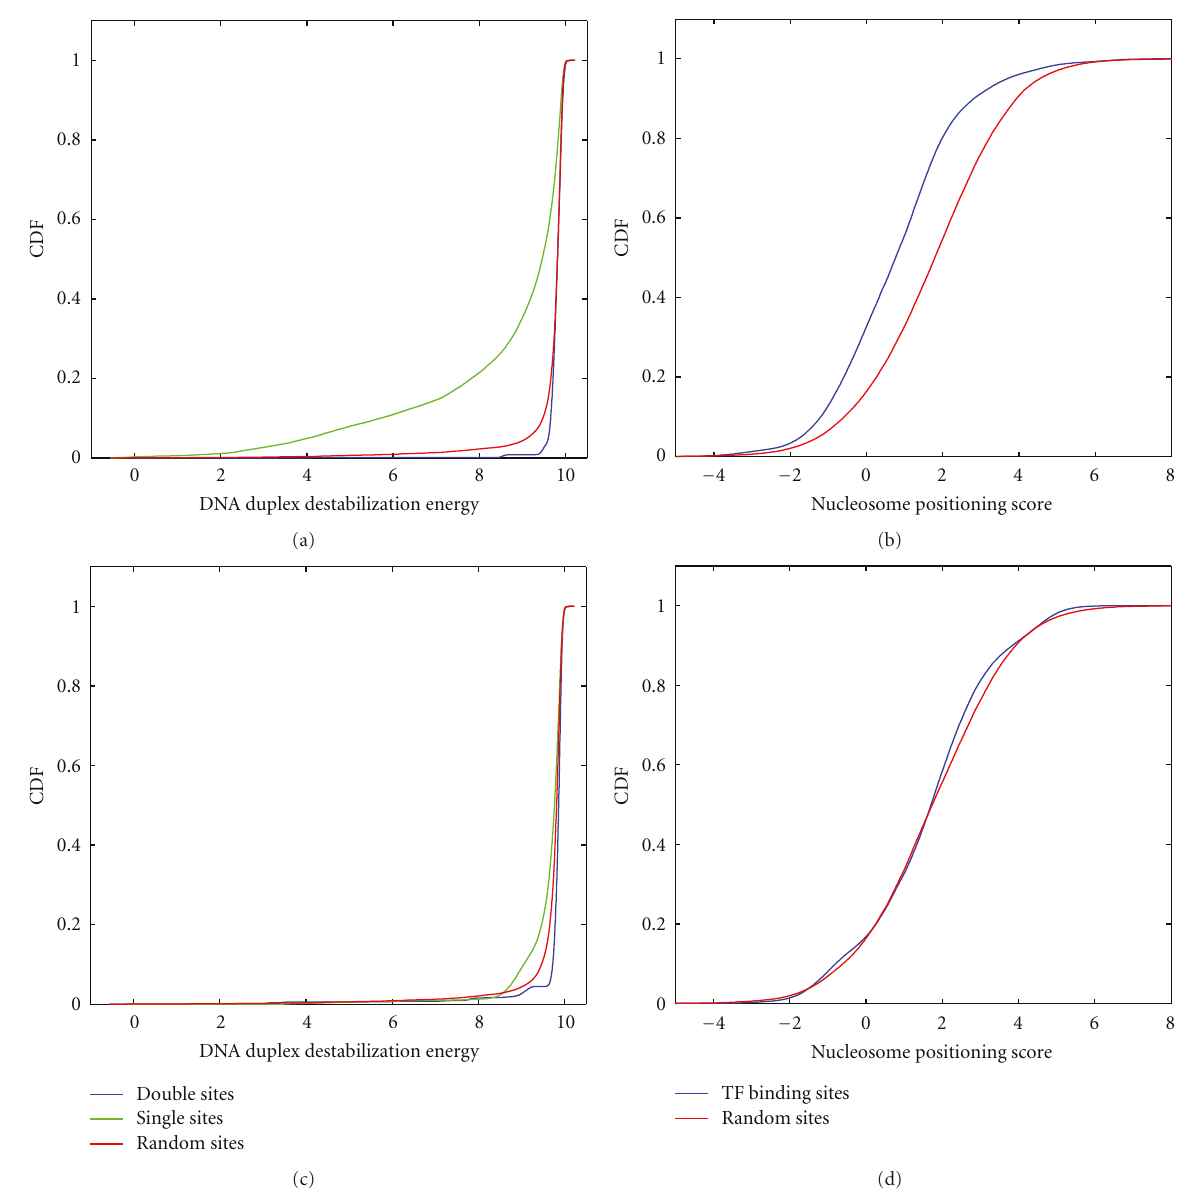
Figure 3: CDFs of novel information sources at known TFBSs and random sites. CDFs of (a) DNA duplex destabilization energies at TFBSs of single-strand, double-strand binding TFs, and random DNA sites, (b) nucleosome occupation scores at known TFBSs and random DNA sites. Panels (c) and (d) are similar with (a) and (b), respectively, but with each information scores shifted